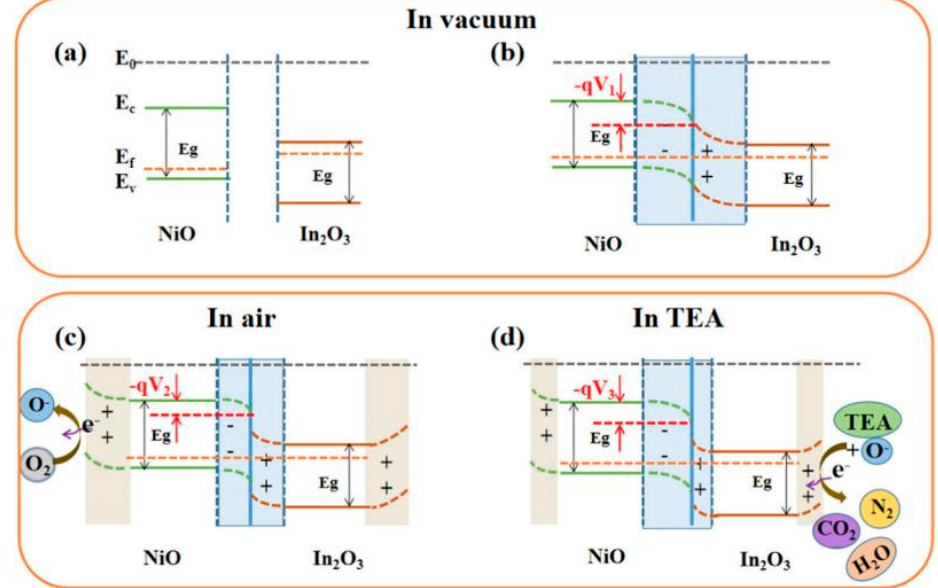
Figure 15. Schematic diagrams of the energy band states of NiO, In 2 O 3 , and In 2 O 3 -NiO, ( a , b ) in a vacuum, ( c ) in air, and ( d ) in TEA [108].